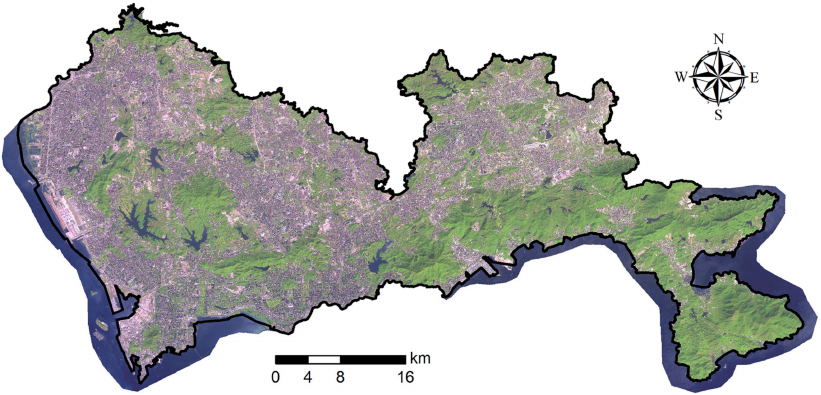
Figure 2. The SPOT-5 images.